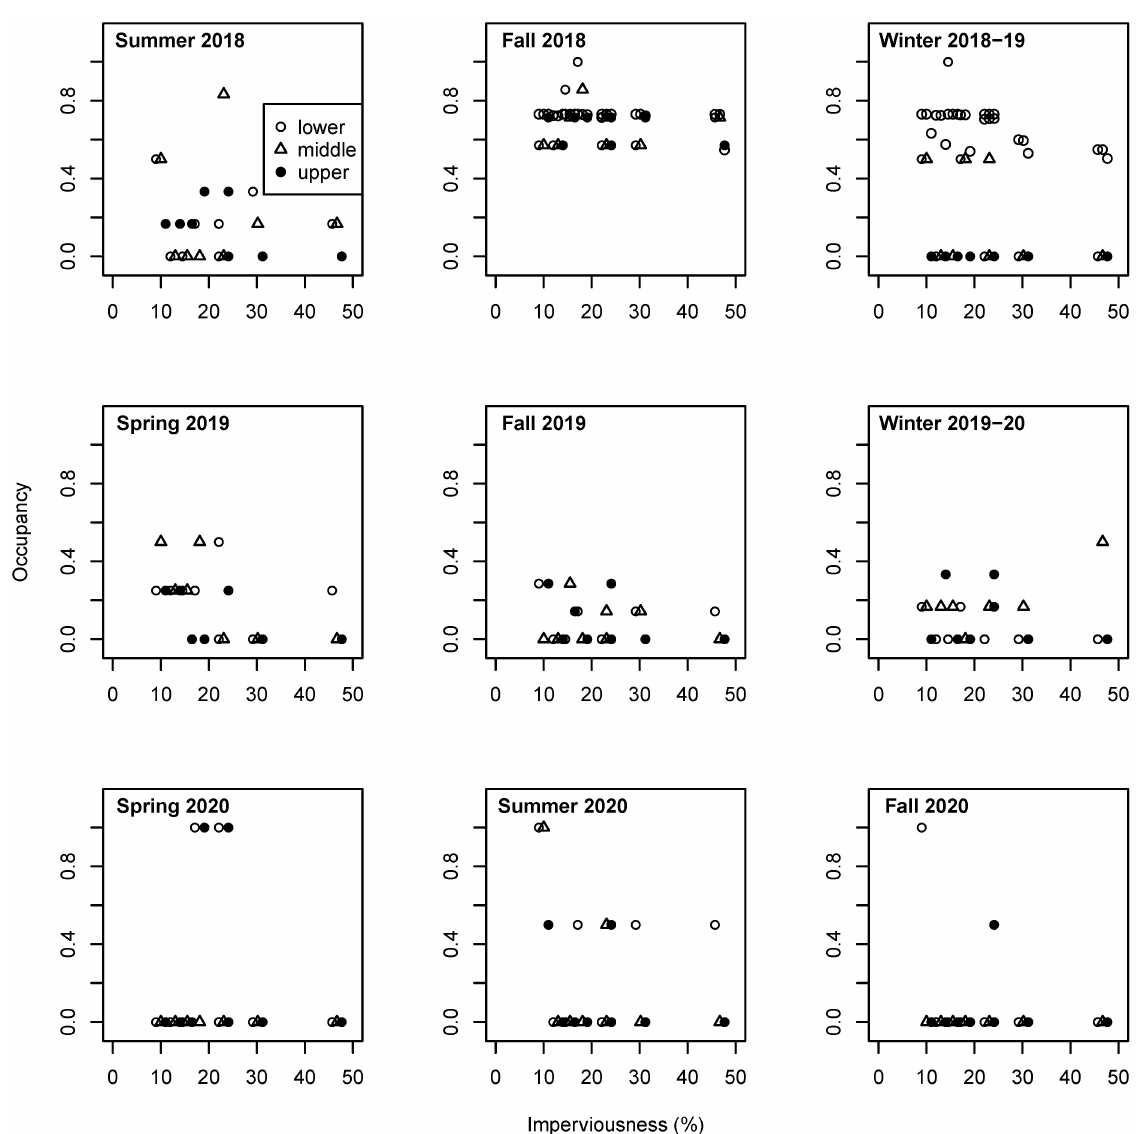
Figure 1. Cybersecurity Awareness Methodology. Figure 2. Observed proportional occupancy of juvenile blue crabs Callinectes sapidus ( y -axis) vs. watershed imperviousness ( x -axis) in eight North Carolina (USA) tidal creeks. Three sites were sampled per creek; each site is jittered around its x -axis value to avoid overlapping symbols with the other two sites in the same creek. Sample sites are labeled according to their position in each creek: lower vs. middle vs. upper sites. The single legend (in the first panel) applies to all graph panels. No sampling occurred in summer